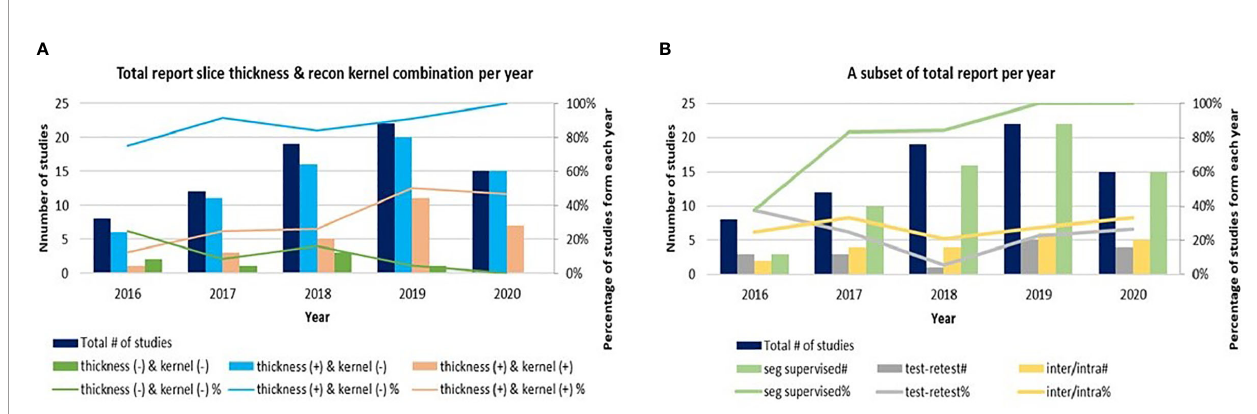
FIGURE 2 | (A) A trend of radiomics studies reporting image acquisition parameters of slice thickness, reconstruction kernels and both. (B) A trend of radiomics studies reporting re-imaging, re-segmentation and supervised segmentation. Due to the small number of radiomics studies published in 2014 and 2015, those studies are excluded from the